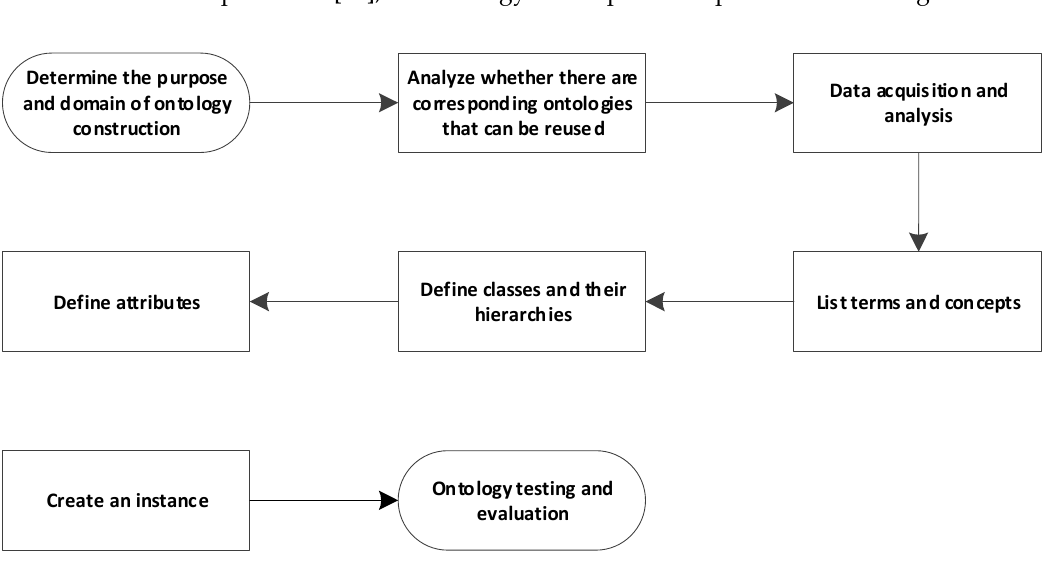
Figure 5. Development steps of the subway risk ontology.